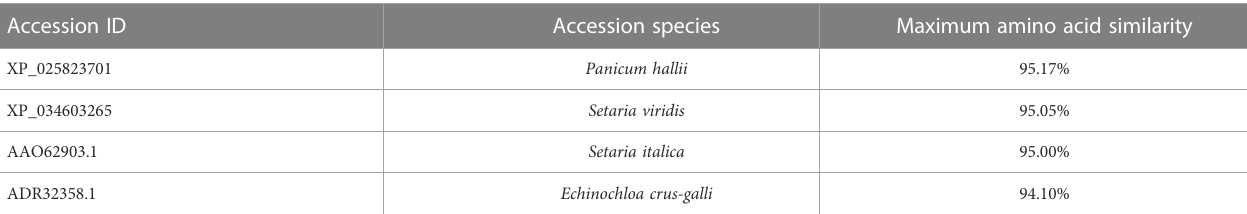
TABLE 6 BLAST results for D . ciliaris var. chrysoblephara ACCase proteins against the NCBI database.